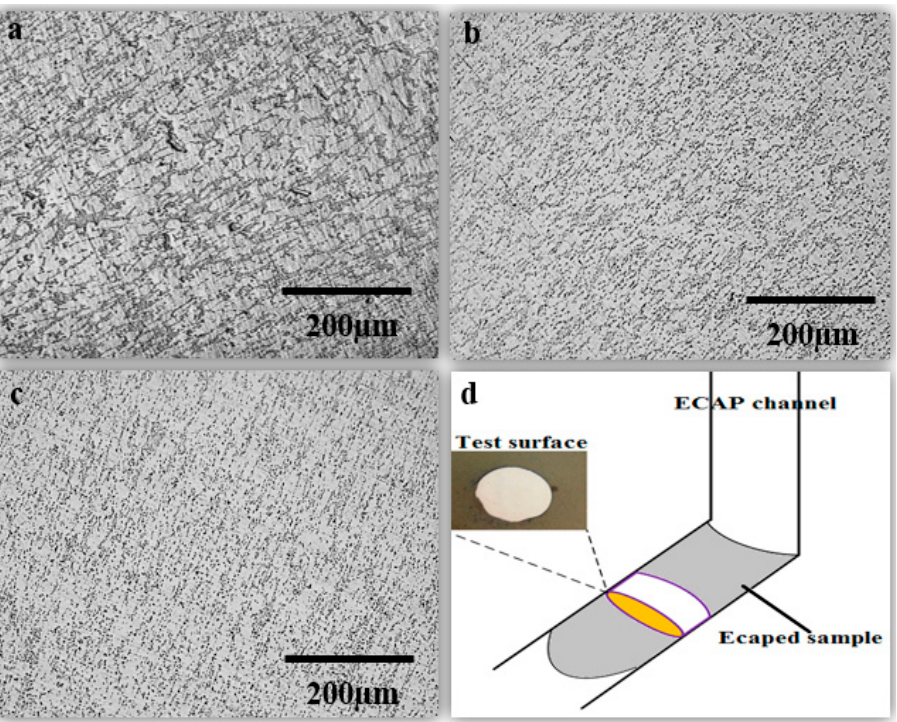
Figure 4. Microstructure of ECAPed-T6 A356 alloy ( a ) as-cast after 4 passes, ( b ) cooling slope after 4 passes, ( c ) cooling slope after 6 passes and ( d ) surface of microscopic ECAPed sample.